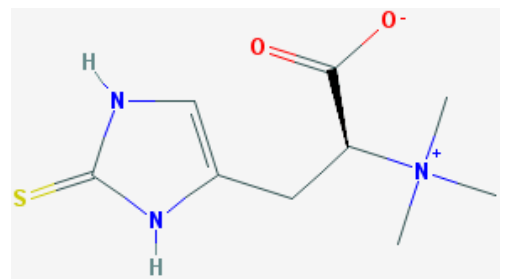
Figure 1. Chemical structure of L